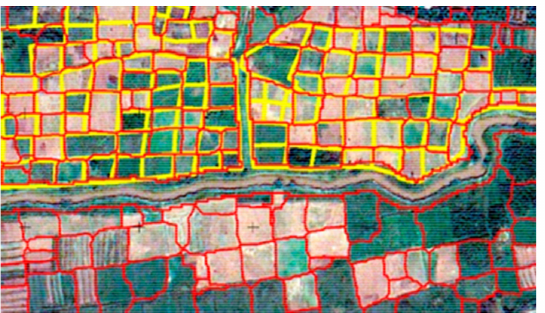
Figure 10. Nyandwai et al.’s method [281] created a ‘first cut’ cadastre (yellow) that could be taken to the field for validation.